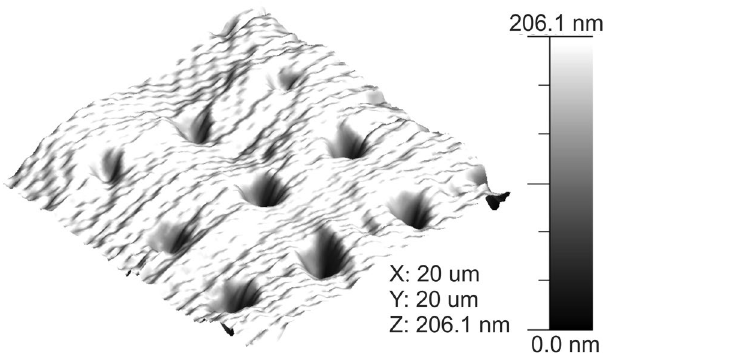
Figure 3. AFM image of PDMS